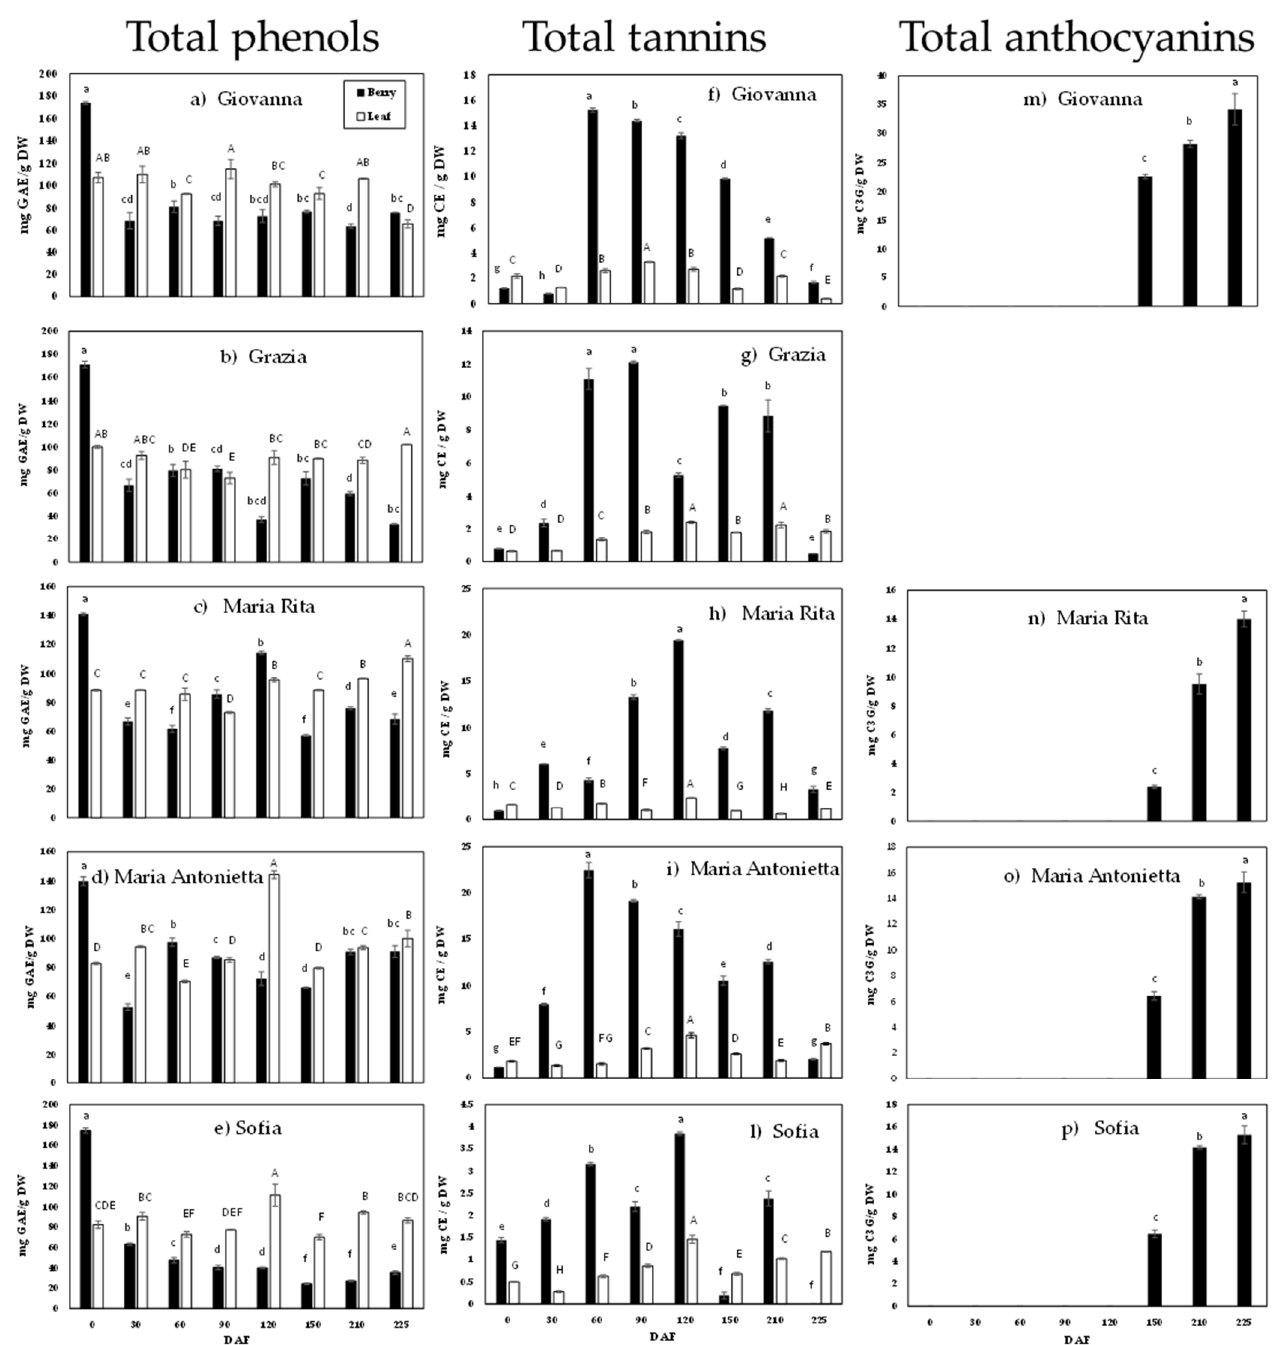
Figure 2. Content of total phenols ( a – e ), tannins ( f – i , l ), and anthocyanins ( m – p ) in leaf and berry extracts of the different cultivars. The ‘Grazia’ cultivar give white fruits. Data are the mean and standard deviation of three replicates. Data labelled with the same letters are not significantly different for components of the berry tissues (lowercase) and leaf tissues (capital) letters according to Duncan’s Multiple Range Test at p ≤ 0.01 level.